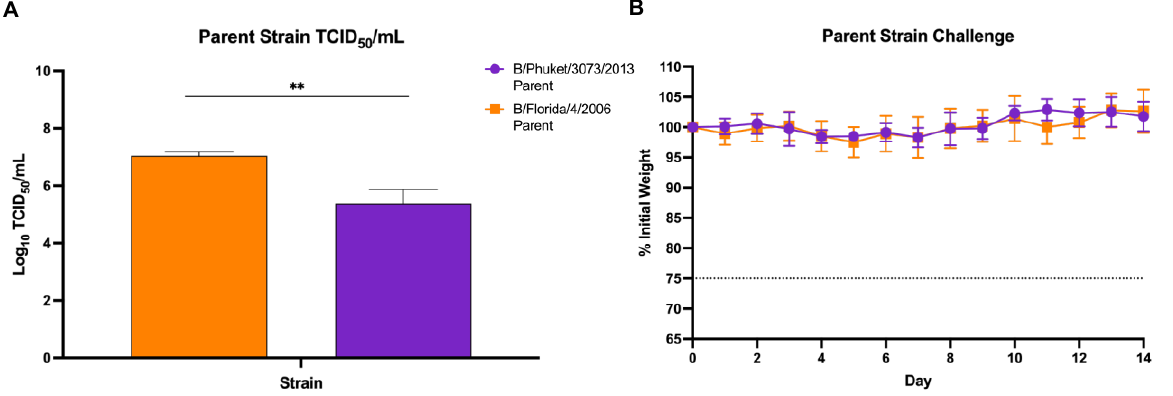
Figure 2. Live challenge with wild-type B/Florida/4/2006 and B/Phuket/3073/2013. ( A ) TCID 50 values for each strain used for initial passage infection. Values shown are an average of three independent experiments with error bars representing standard deviation between three independent replicates. Statistical significance was determined through unpaired t -test, ** p < 0.01; ( B ) Weight loss over 14 days shown after i.n. infection with 1:2 dilution of allantoic fluid of each parent virus. A ≥ 25% initial weight lost (dotted line) was used as a threshold for humane sacrifice of the